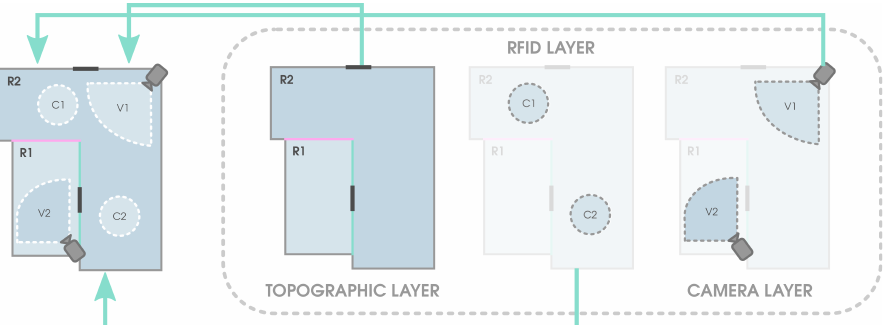
Figure 1. Example of topology, camcorder coverage, and Radio Frequency Identification (RFID) coverage layers of the same building